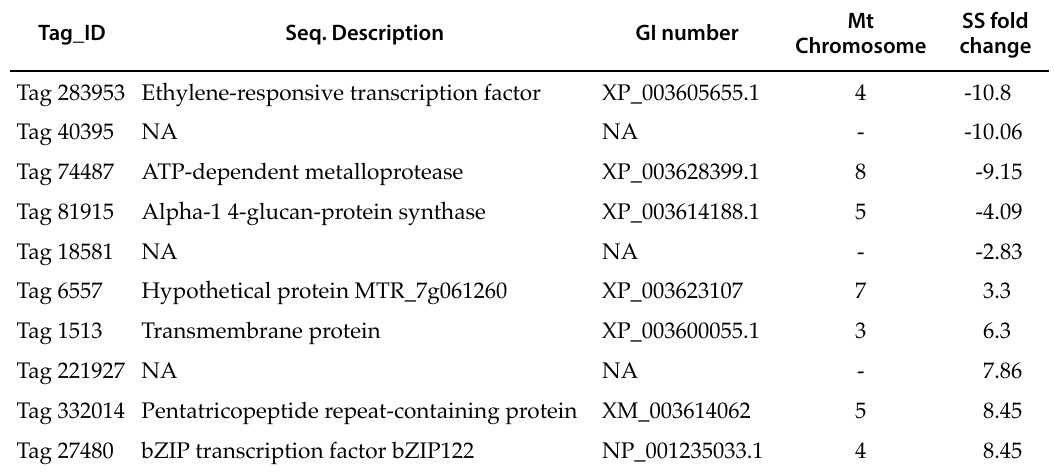
Mt SS fold Chromosome change